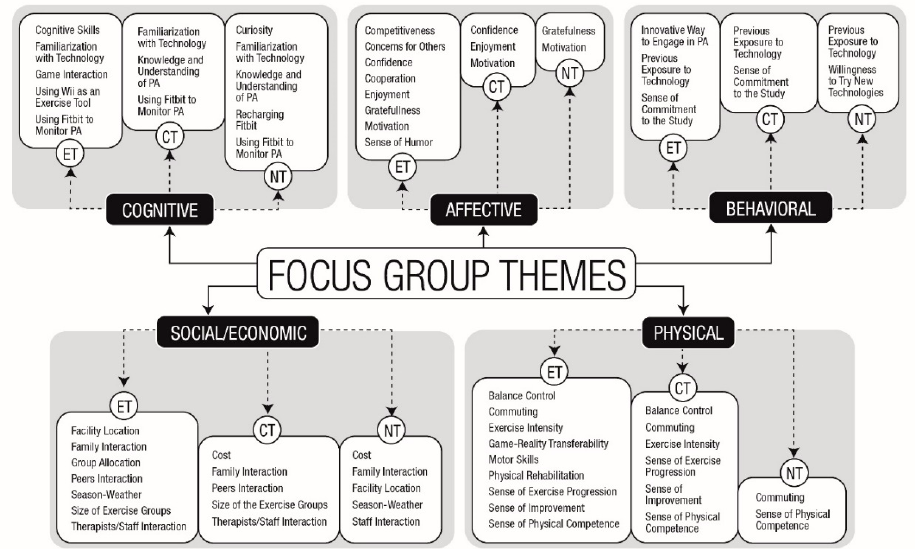
Figure 1. Themes and subthemes that emerged from the discussions of each focus group. Abbreviations: PA—physical activity; ET—exergame training; CT—conventional training; NT—no